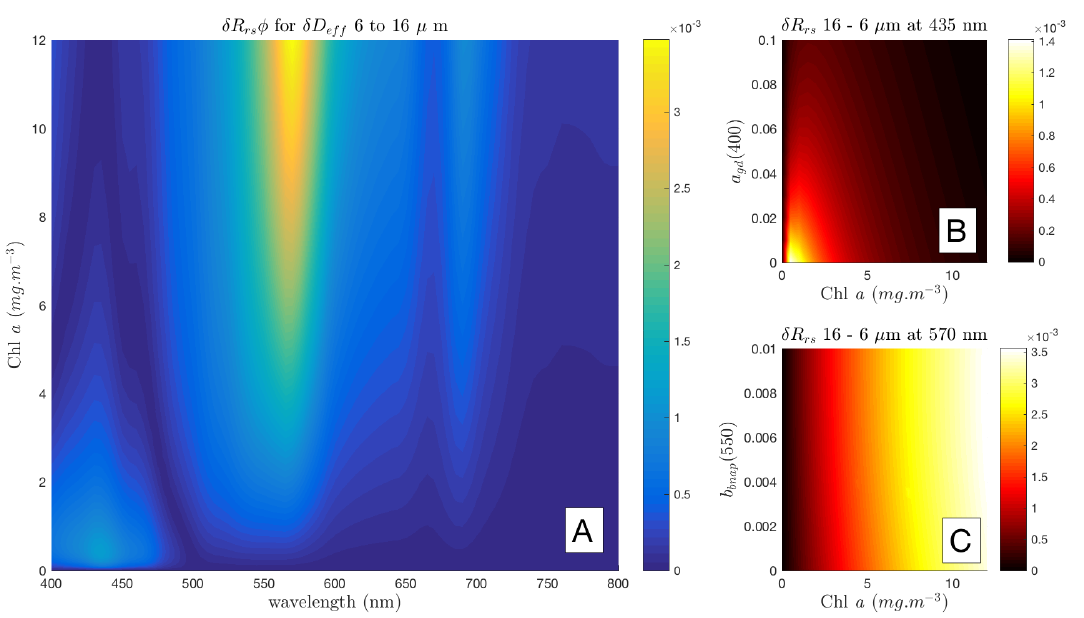
Figure 4. Southern Ocean stations 20 to 21: δ R rs φ is shown for δ D ef f of 6 to 16 µ m ( A ). The effect of a gd ( λ ) at 435 nm is shown in ( B ), and b bnap ( λ ) at 570 nm in ( C ). The units of the colour bars are sr − 1 . Working with the change in phytoplankton size signal identified at 435 nm (bottom left